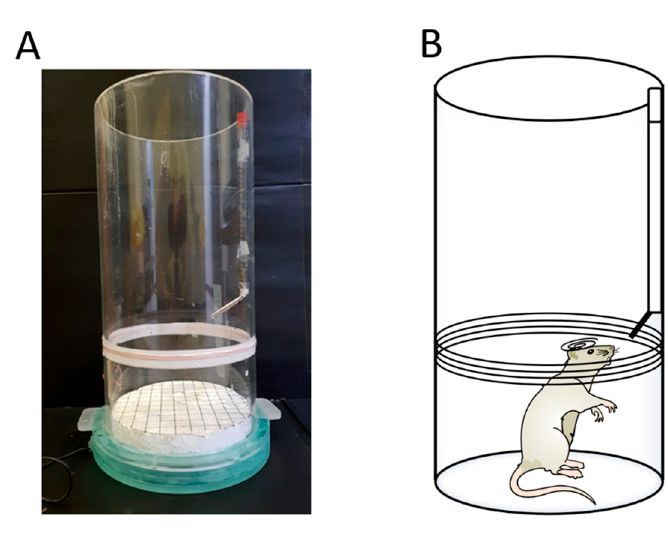
Figure 9. Conditioned taste aversion test with optogenetic photostimulation. ( A ) The wireless remote-controlled device was applied in the conditioned taste aversion learning task; a drinking tube was linked to the enclosed wall of the wireless remote-controlled device. ( B ) An illustration showing an animal with photostimulation licking the drinking fluid tube after conditioned taste aversion.